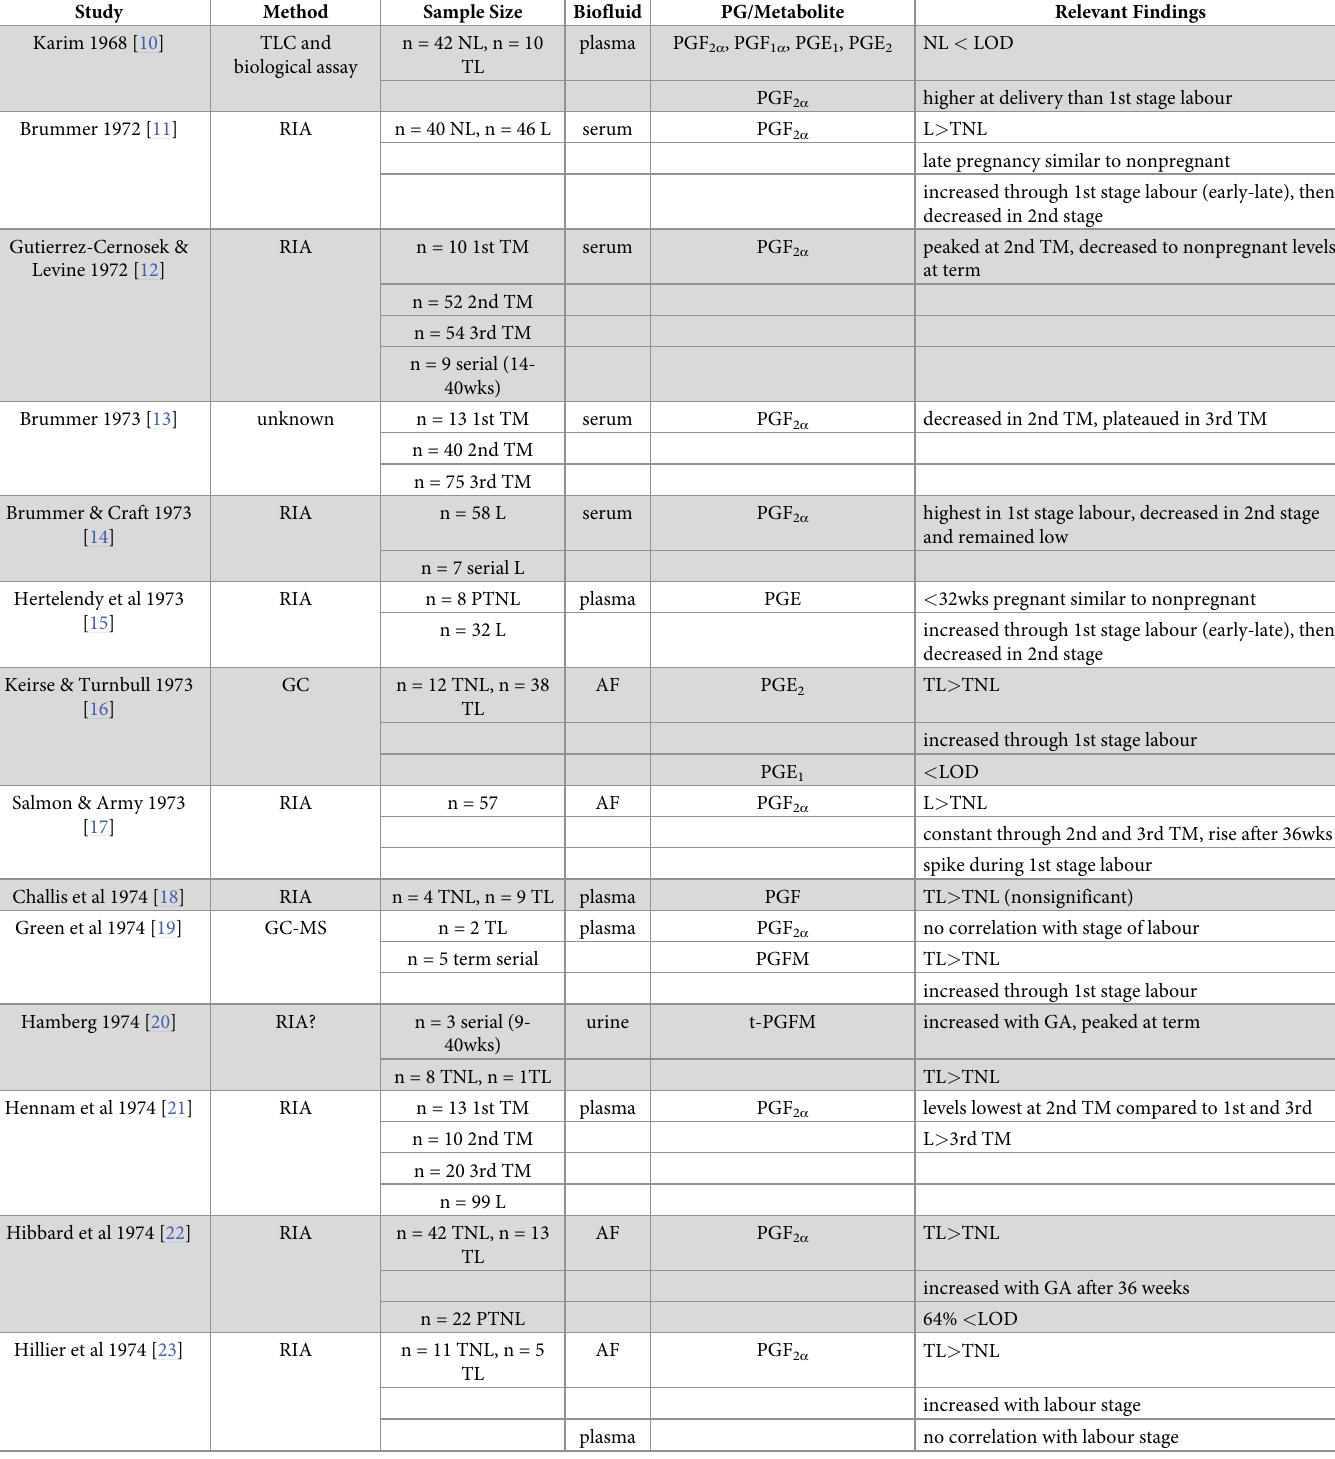
Table 2. Main characteristics of